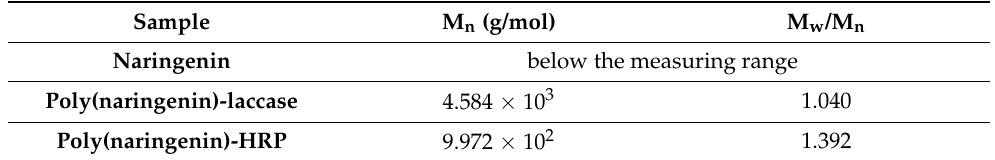
Figure 4. Gel permeation chromatography GPC traces of poly(naringenin)-laccase and poly(naringenin)-HRP samples.